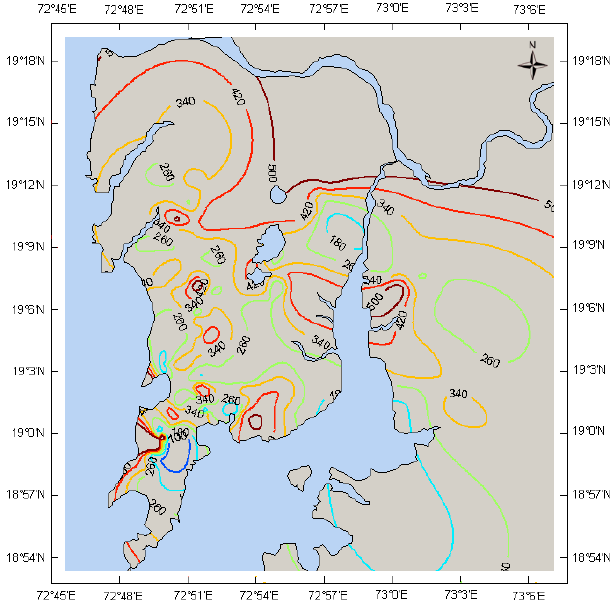
Fig. 2. Contour map of spatial distribution of mean shear wave ve- locity for Mumbai city.